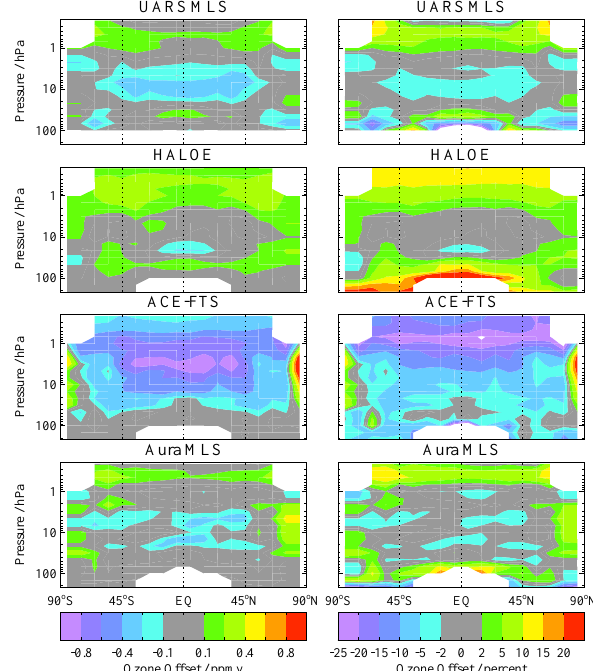
Figure 19. Offsets applied to the O 3 source data sets, similar to Fig. 2 for